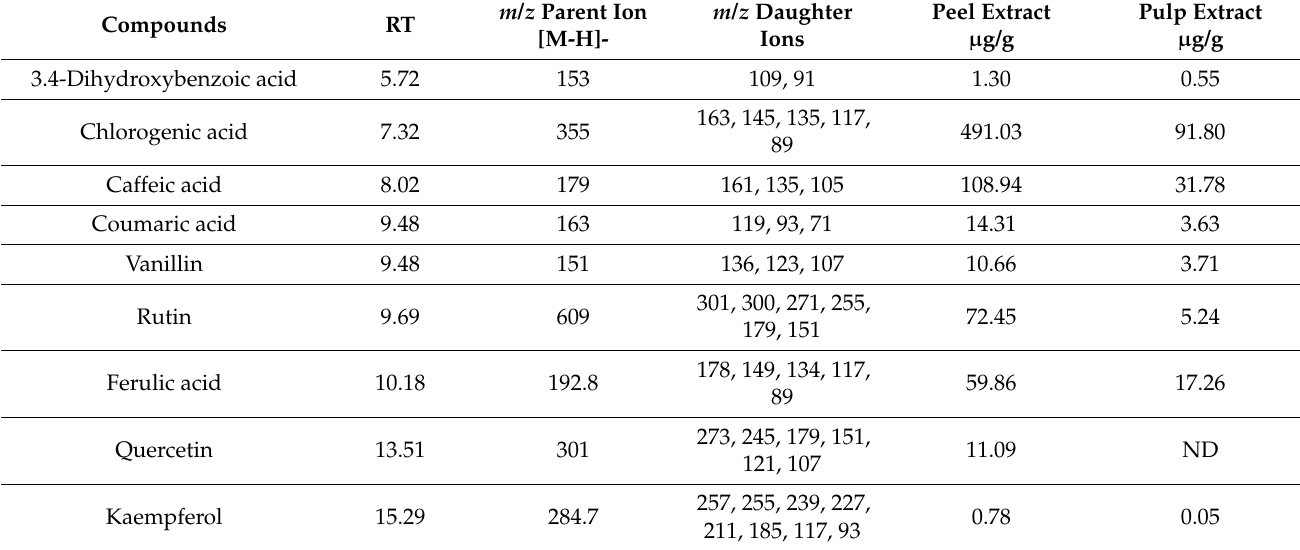
Table 3. LC-MS analysis of the peel and pulp extracts of H. undatus .